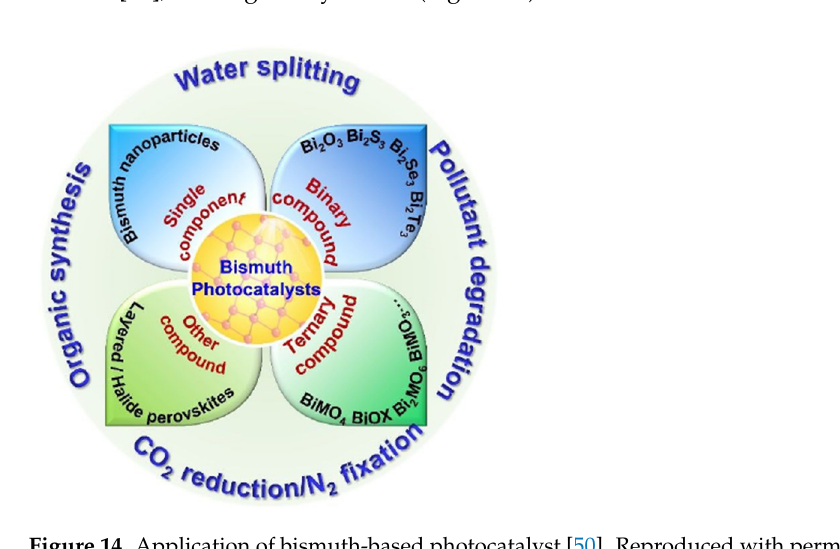
Figure 14. Application of bismuth-based photocatalyst [50]. Reproduced with permission from Wang et al. Copyright © 2022 The Royal Society of Chemistry.